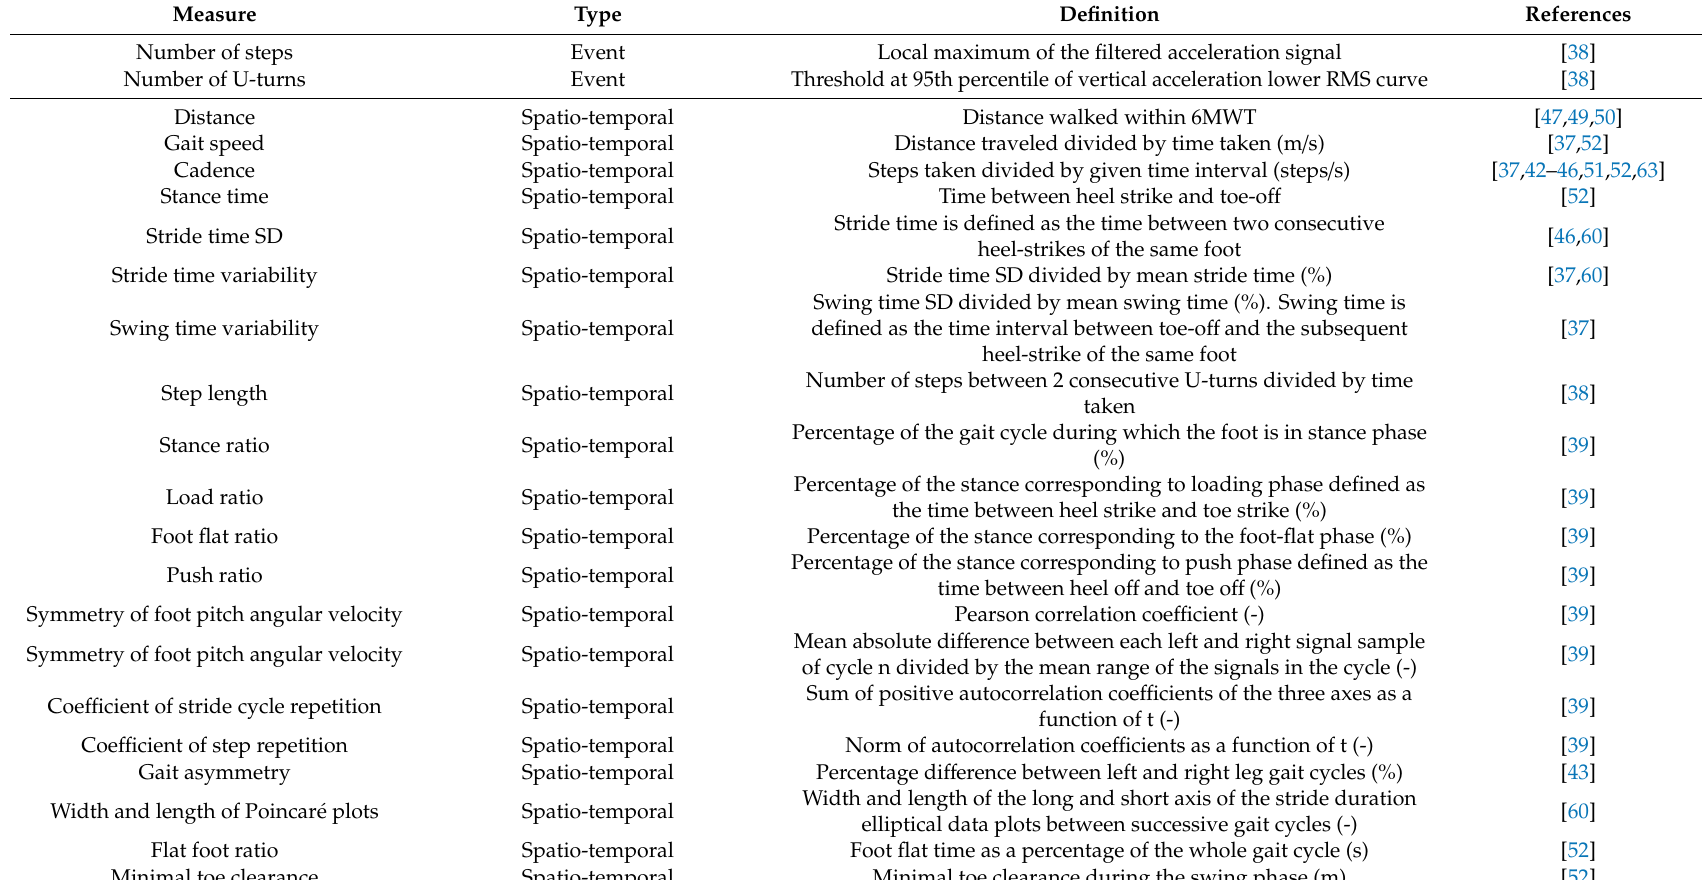
Table 4. Summary and definition of the main outcome parameters of the reviewed